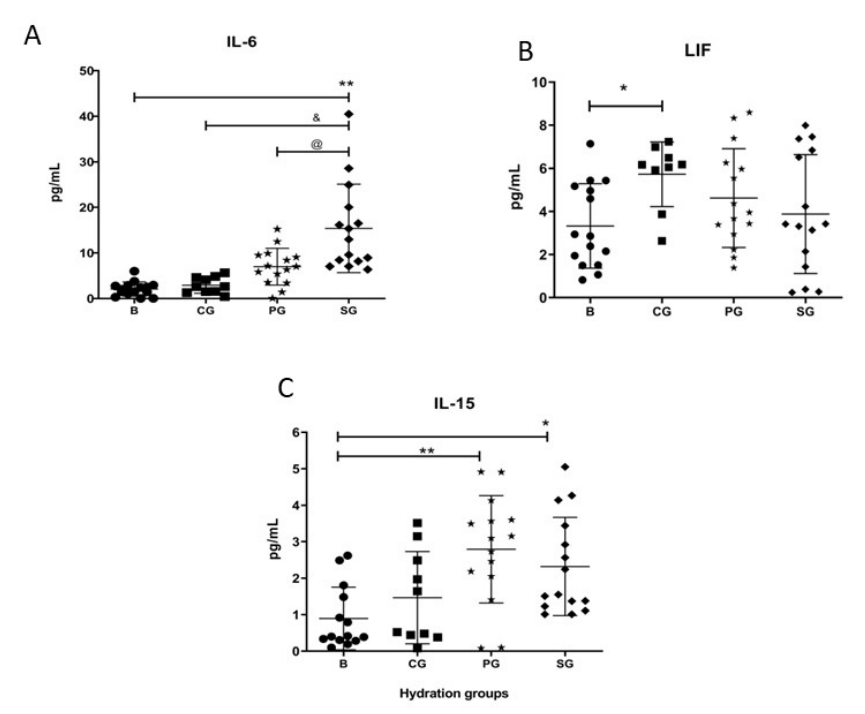
Figure 2. Expression of myokine proteins. ( A ) The IL-6 levels just increased post-exercise in experimental group (SG). ( B ) Leukemia Inhibitory Factor (LIF) values increased post-exercise only in the SG. ( C )